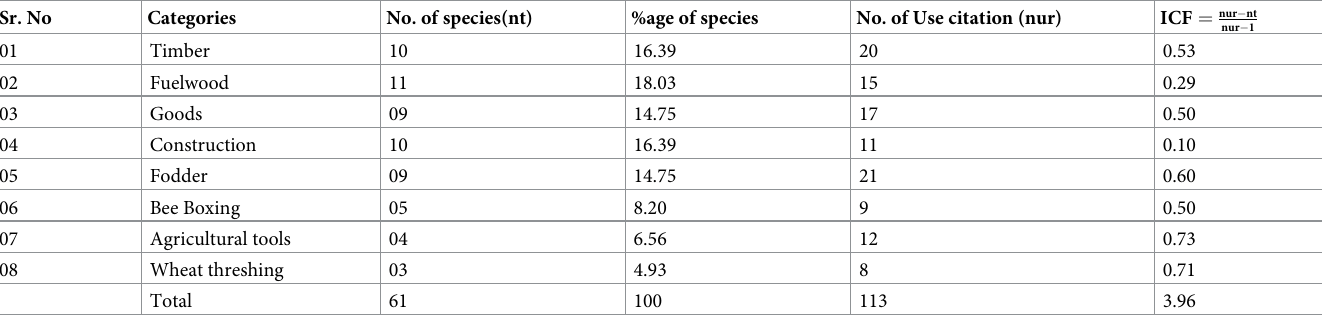
Table 2. ICF value of ethnobotanical uses of tree plants of SRM of District Bhimber AJK, Pakistan. Sr.